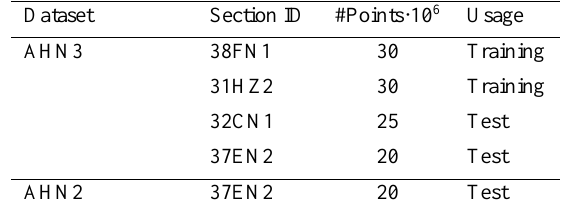
Table 1. Overview of used data from the second (AHN2) and third (AHN3) version of the Dutch national point